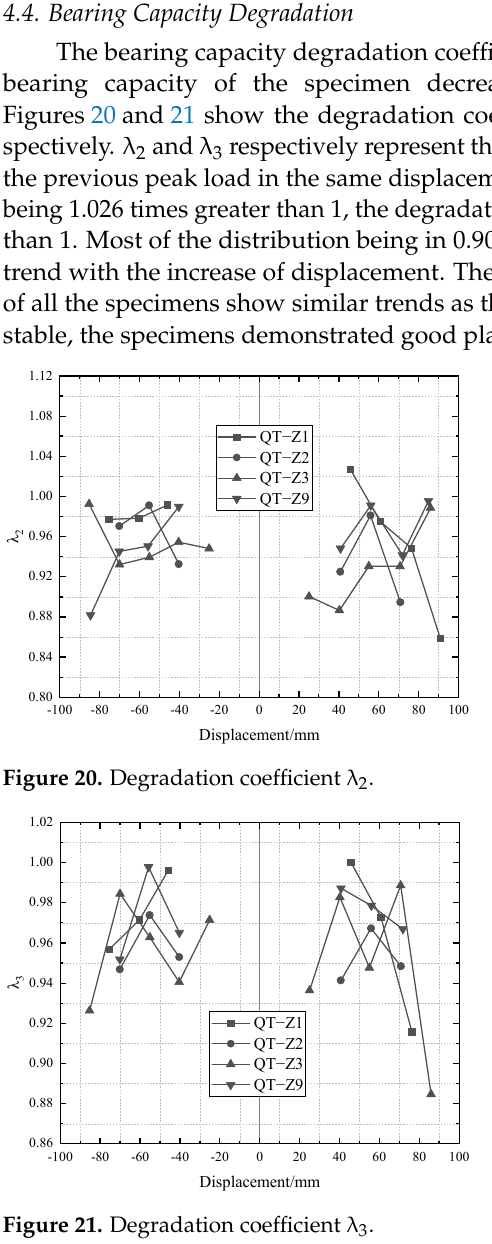
Figure 19. Stiffness degradation curves.